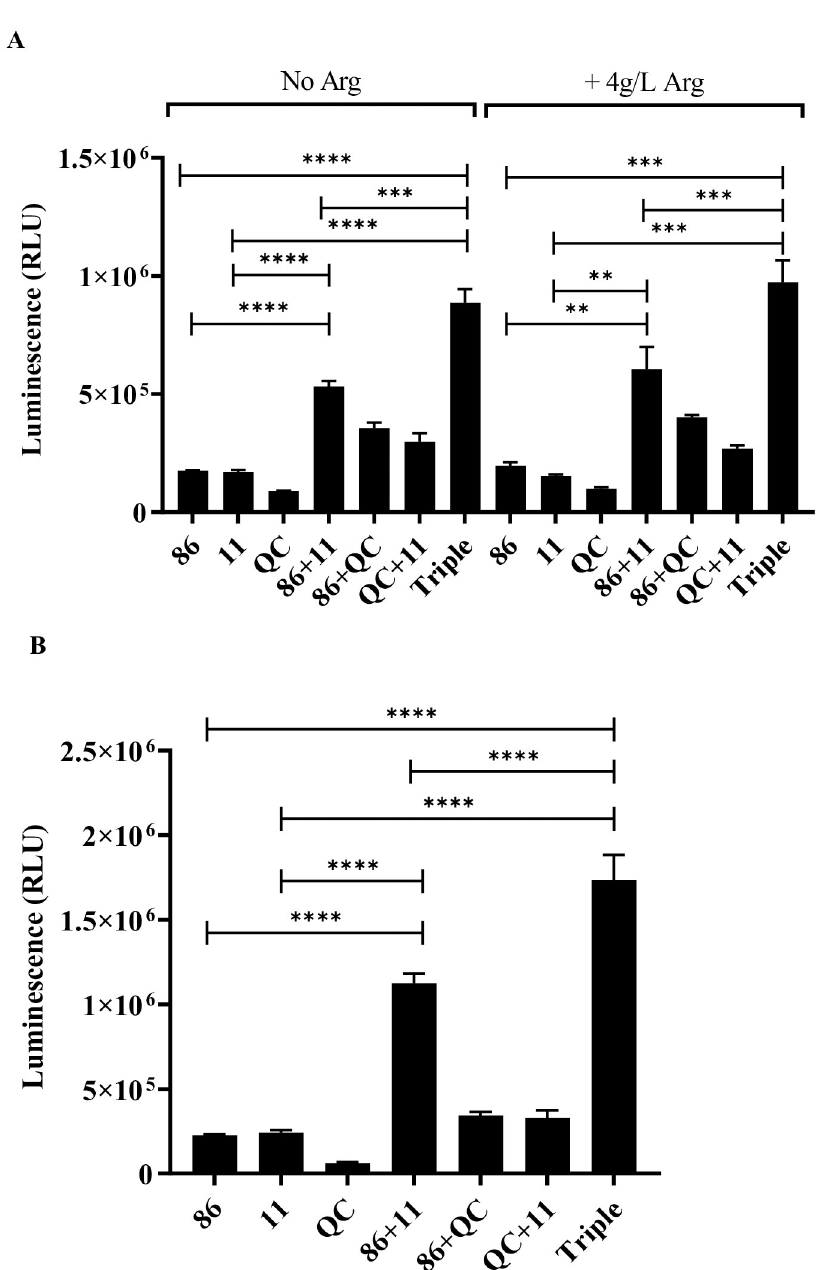
Fig 5. ATP production is enhanced in dual- and triple-species cultures. ATP production measured by luminescence (relative light units, RLU), of H . influenzae 86-028NP (86), S . pneumoniae 11 and M . catarrhalis QC following 2 h of incubation in single-species culture, dual-species culture, and triple species culture at A) pH 8, with and without arginine supplementation, and B) in pH 7, without arginine supplementation. Significant differences were observed between H . influenzae alone (86), in dual-species culture with S . pneumoniae (86+11), and in triple-species culture (Triple). Statistical significance was evaluated with a student’s t-test ( �� p < 0.01, ��� p < 0.001, ���� p �